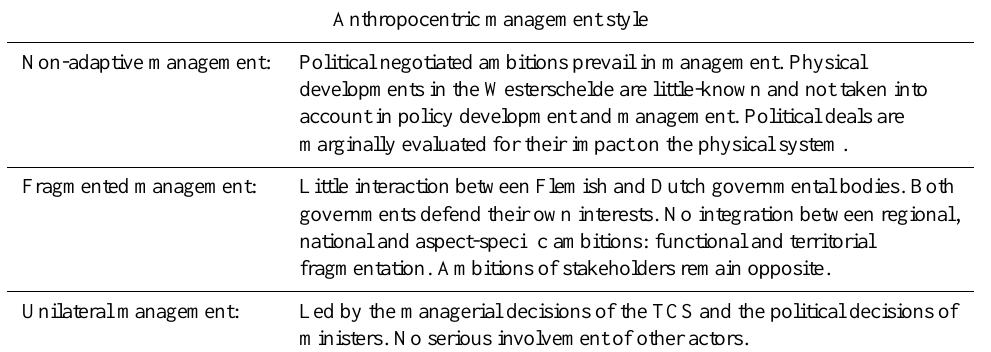
Table 5. Management style